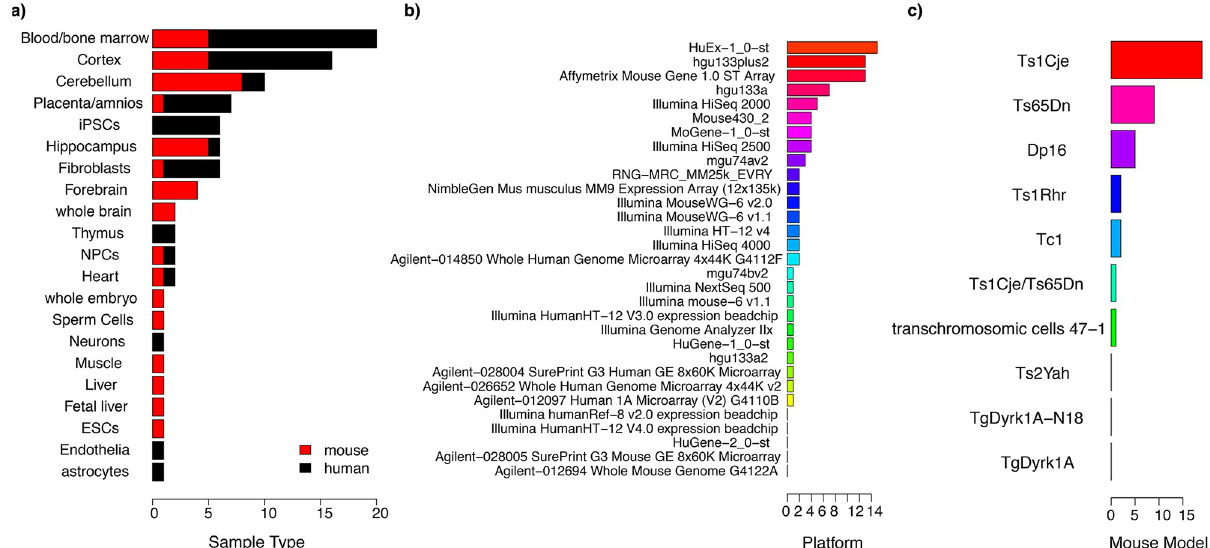
Fig 1. Transcriptomic data used for the meta-analysis. The datasets used derive from both individuals with DS and DS mouse models, and span different tissues, sex, ages and treatment effects. a ) Barplot showing the number of transcriptomic datasets for each tissue in Mus Musculus (red) and Homo sapiens (black). b) Number of transcriptomic datasets using each sequencing platform. c) Number of transcriptomic datasets for each DS mouse